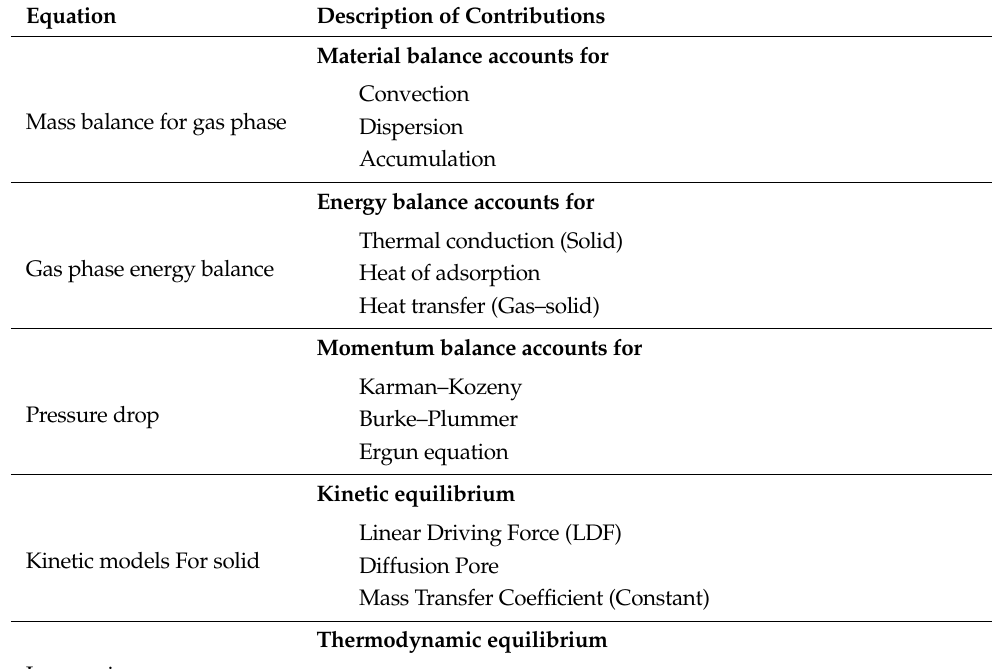
Table 1. Equations used for modeling the PSA process and hydrogen